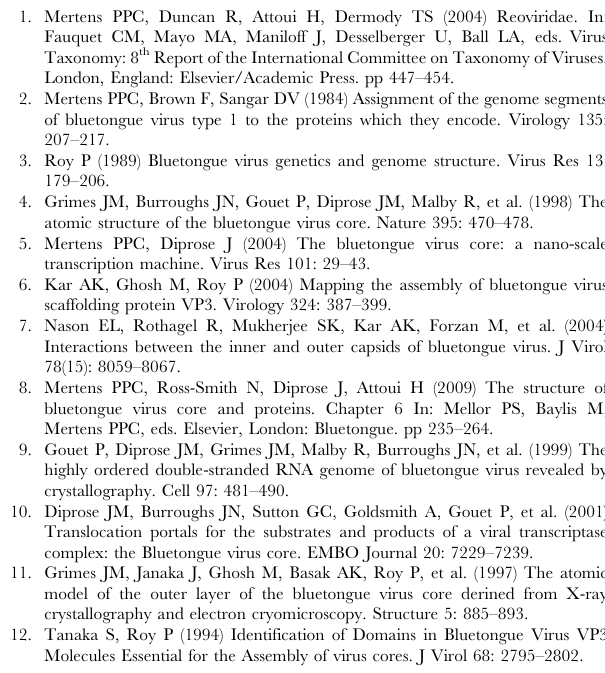
parametric bootstrap (NPB) probabilities and only values with P . 0.6 are shown. Figure S2 Phylogenetic tree inferred with maximum likelihood analysis using the middle region of BTV Seg-3 (nucleotides 909 to 1778) and the GTR + I + C model. The viruses included are indicated in tables 1 and 2. Isolate abbreviations: Serotype/origin